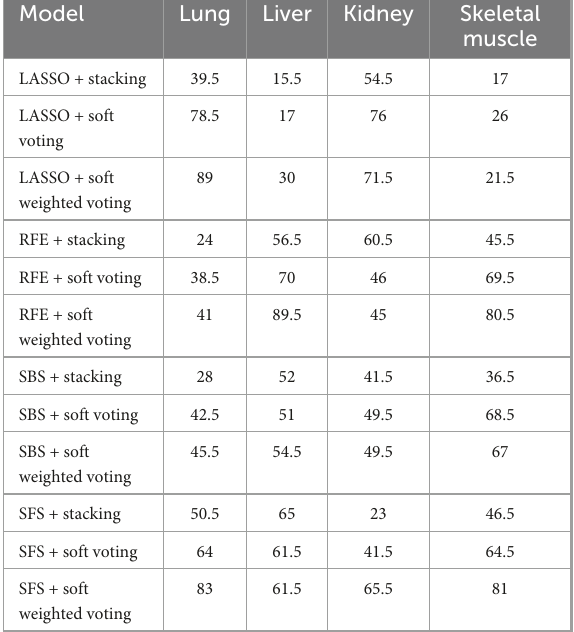
TABLE 3 The scores of ensemble models based on four